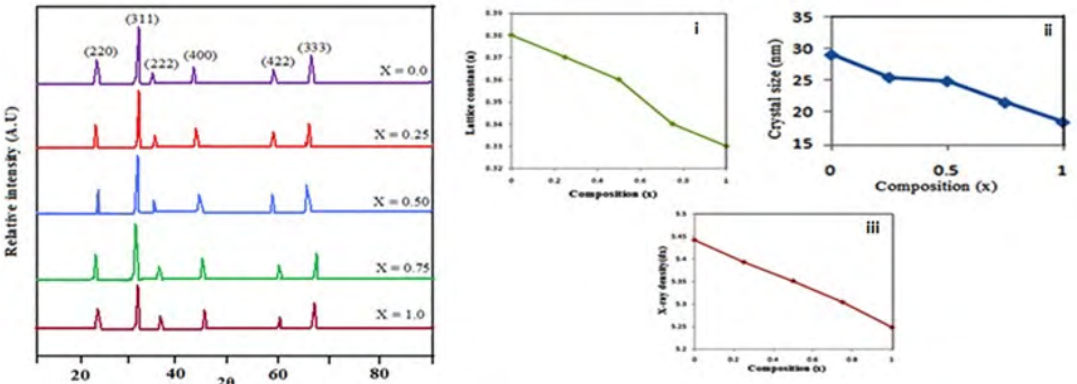
Ni AlCrO (x = 0.0, 0.25, 1-x x 4